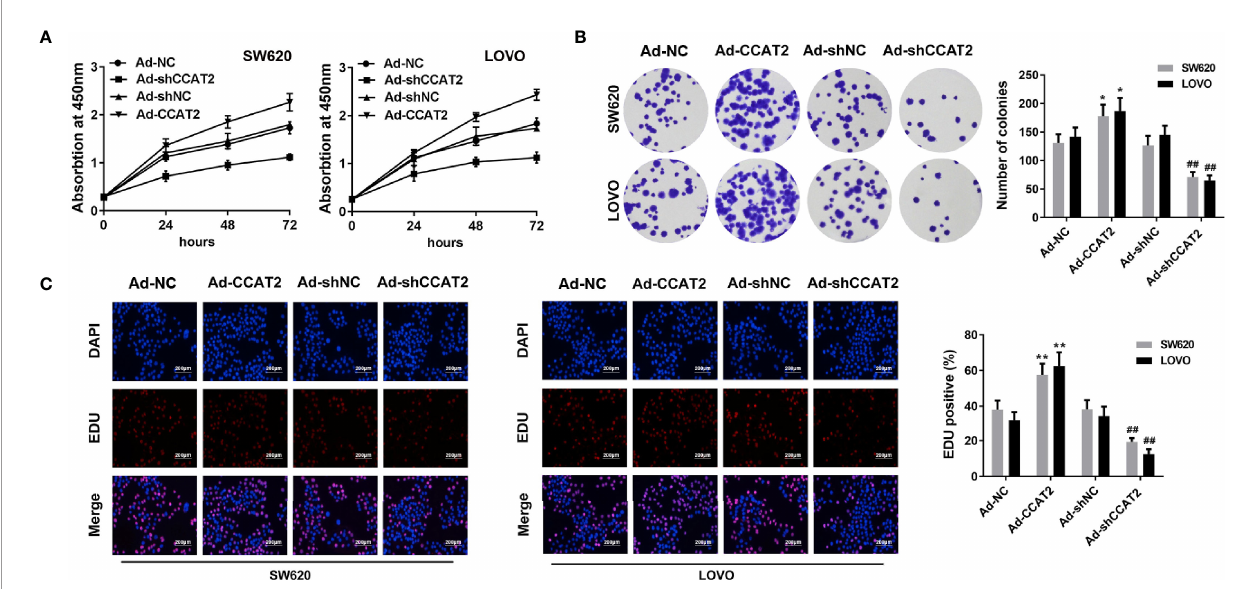
FIGURE 2 | Overexpression of CCAT2 promoted cell proliferation in CRC. The SW620 and LOVO cells were infected with Ad-CCAT2, Ad-shCCAT2 or empty vector. (A) Cell viability was assessed through CCK8 assay. (B) Colony formation ability was enhanced in SW620 and LOVO cells overexpressing CCAT2 while being reduced by CCAT2 knockdown, as shown by cell colony assay. Data are represented as mean ± SD. (C) Cell proliferation was evaluated by EdU staining (×400). The data are represented as mean ± SD. Three independent biological repeats were used for each analysis. *P < 0.05, **P < 0.01 vs Ad-NC, ## P < 0.01 vs